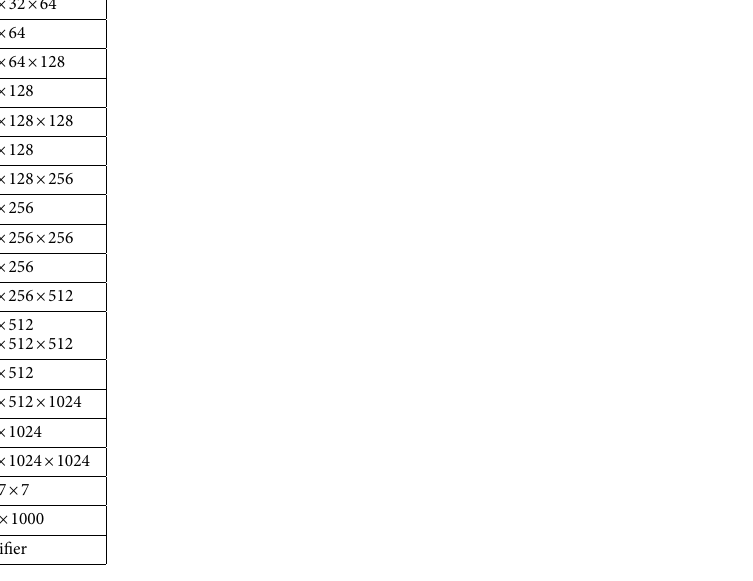
Table 2. MobileNet network